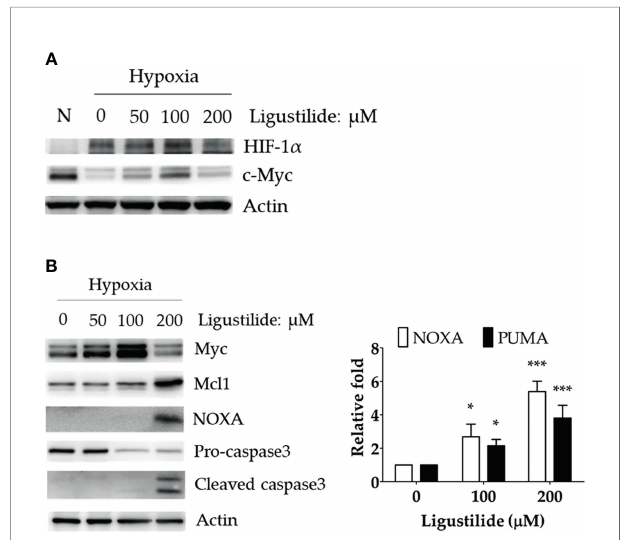
FIGURE 2 | Effect of ligustilide on HIF-1 a and c-Myc protein levels in hypoxic TW2.6 cells. (A) TW2.6 cells were treated with ligustilide and incubated at 37°C of hypoxia for 24 h. Cells were harvested and protein was analyzed by Western blot. A normoxia (N) group was performed as a control group compared to hypoxia. (B) Cells were treated with ligustilide in different doses and incubated at 37°C of hypoxia for 24 h. Protein (left) and mRNA (right) were harvested and analyzed. Data in the plot are expressed as mean ± SEM ( n ≥ 3). *P-valve < 0.05; ***P-valve <